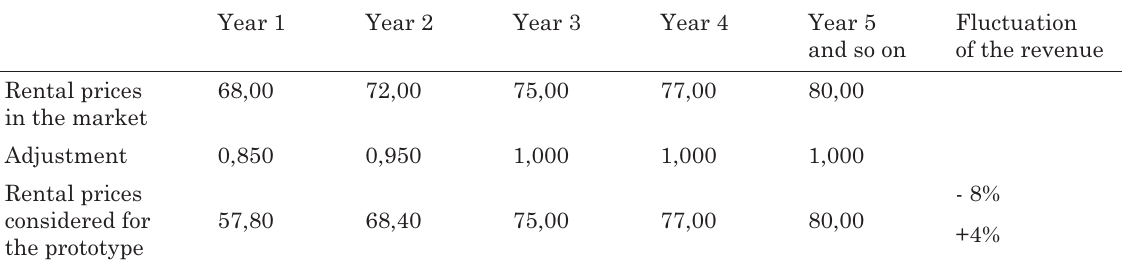
Table 1. Scenario for the operational cycle – rental